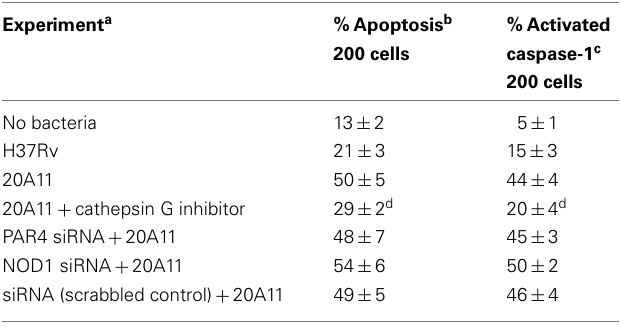
Table 3 | Cathepsin G activity from samples of cell lysates of U937 macrophages.